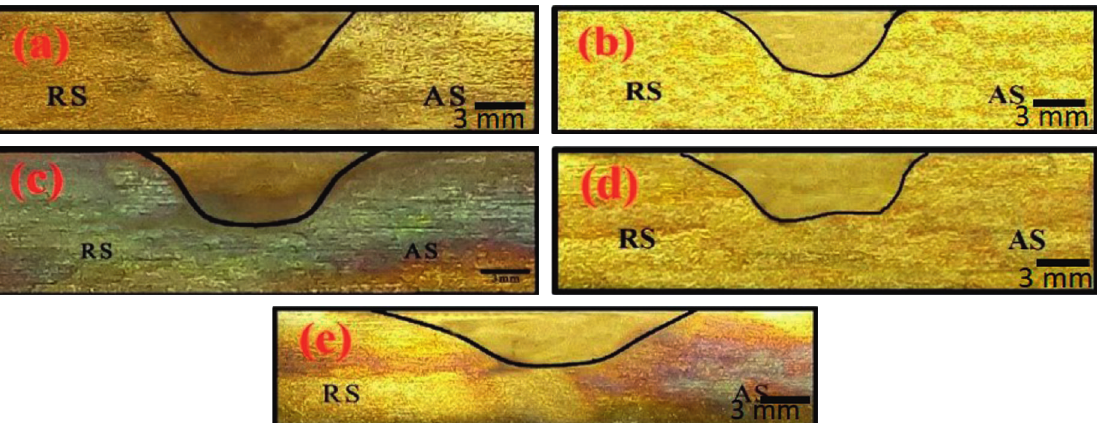
Figure 5: Macro images of CuNi/B 4 C surface composite at tool rotational speed of (a) 1000rpm, (b) 1100rpm, (c) 1200rpm, (d) 1300rpm, and (e) 1400rpm.